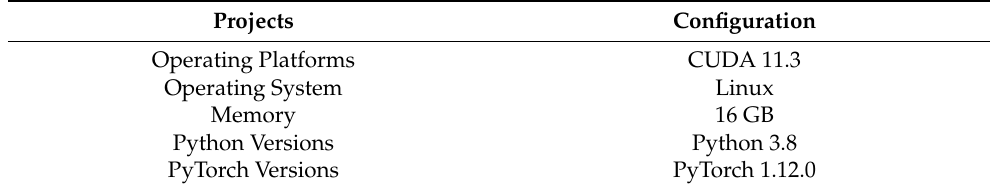
Table 2. Experimental environment.